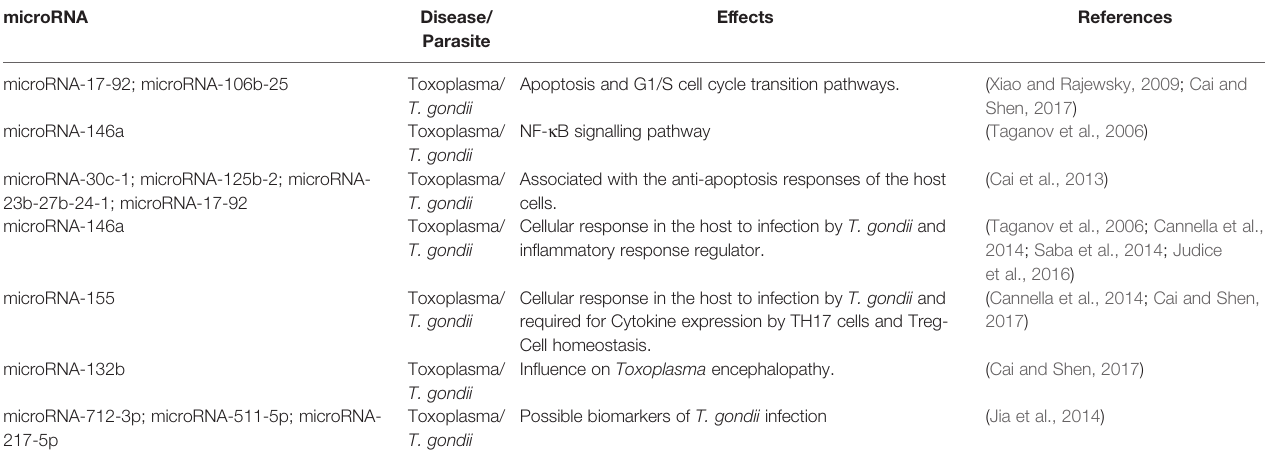
TABLE 1 | The role of microRNAs in toxoplasmosis diseases.